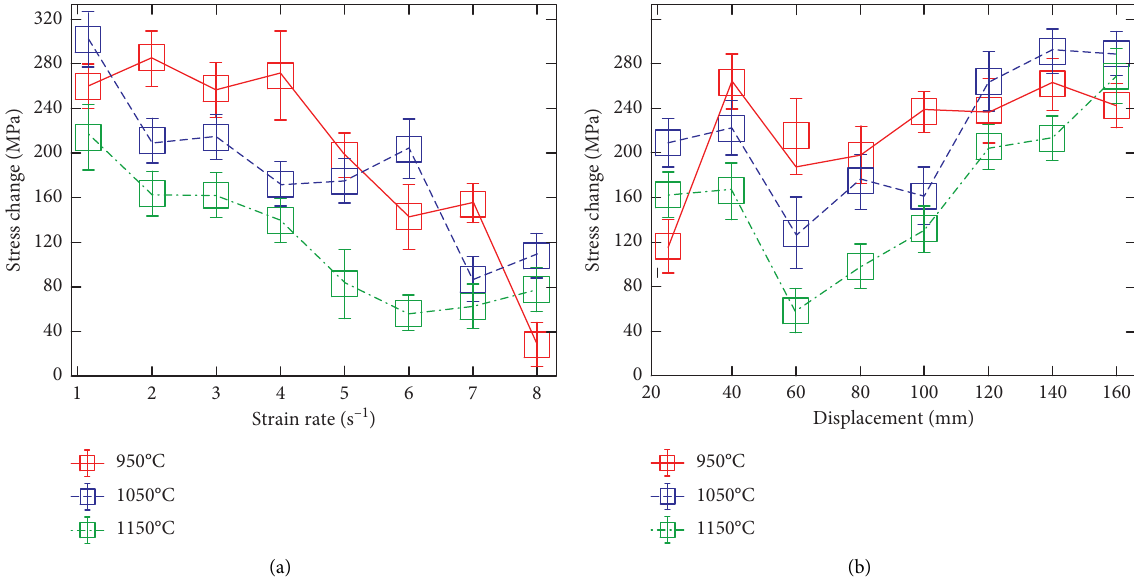
Figure 6: Relationship between stress change and strain rate. (a) Displacement. (b) Mental material in the solid-state processing.